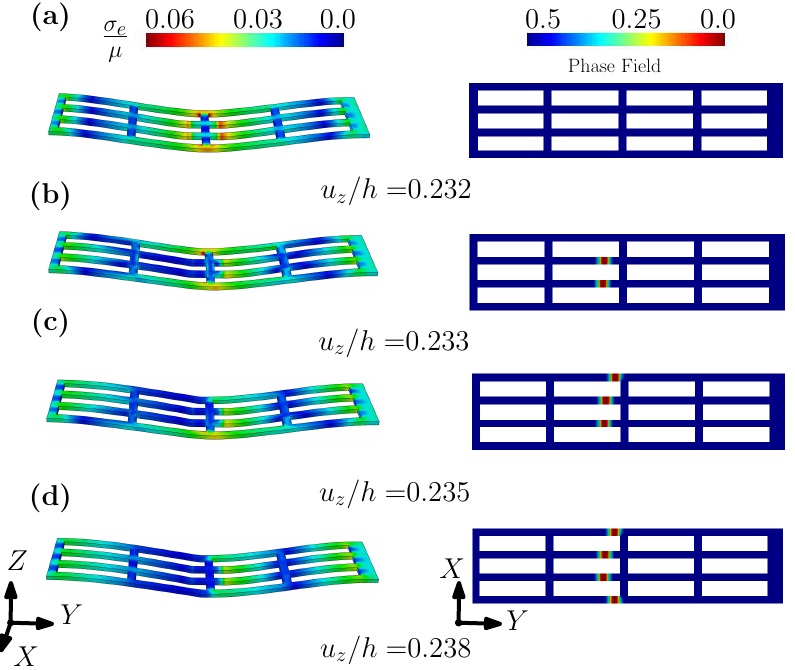
Figure 12. The contour plots of normalized effective Cauchy stress and phase field under different displacement u z / h =: ( a ) 0.232; ( b ) 0.233; ( c ) 0.235; ( d )